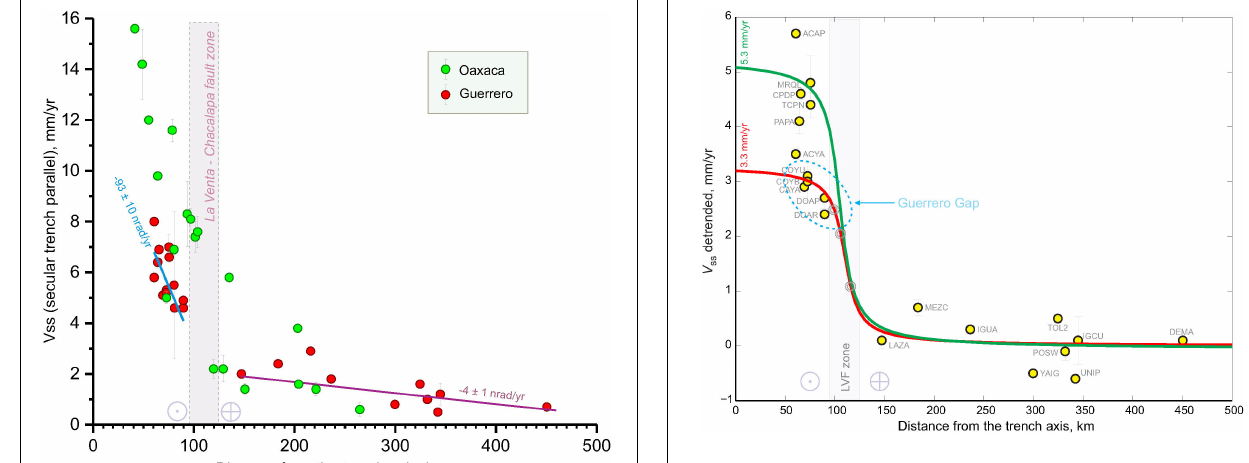
89 shallow thrust events that corresponded only to the